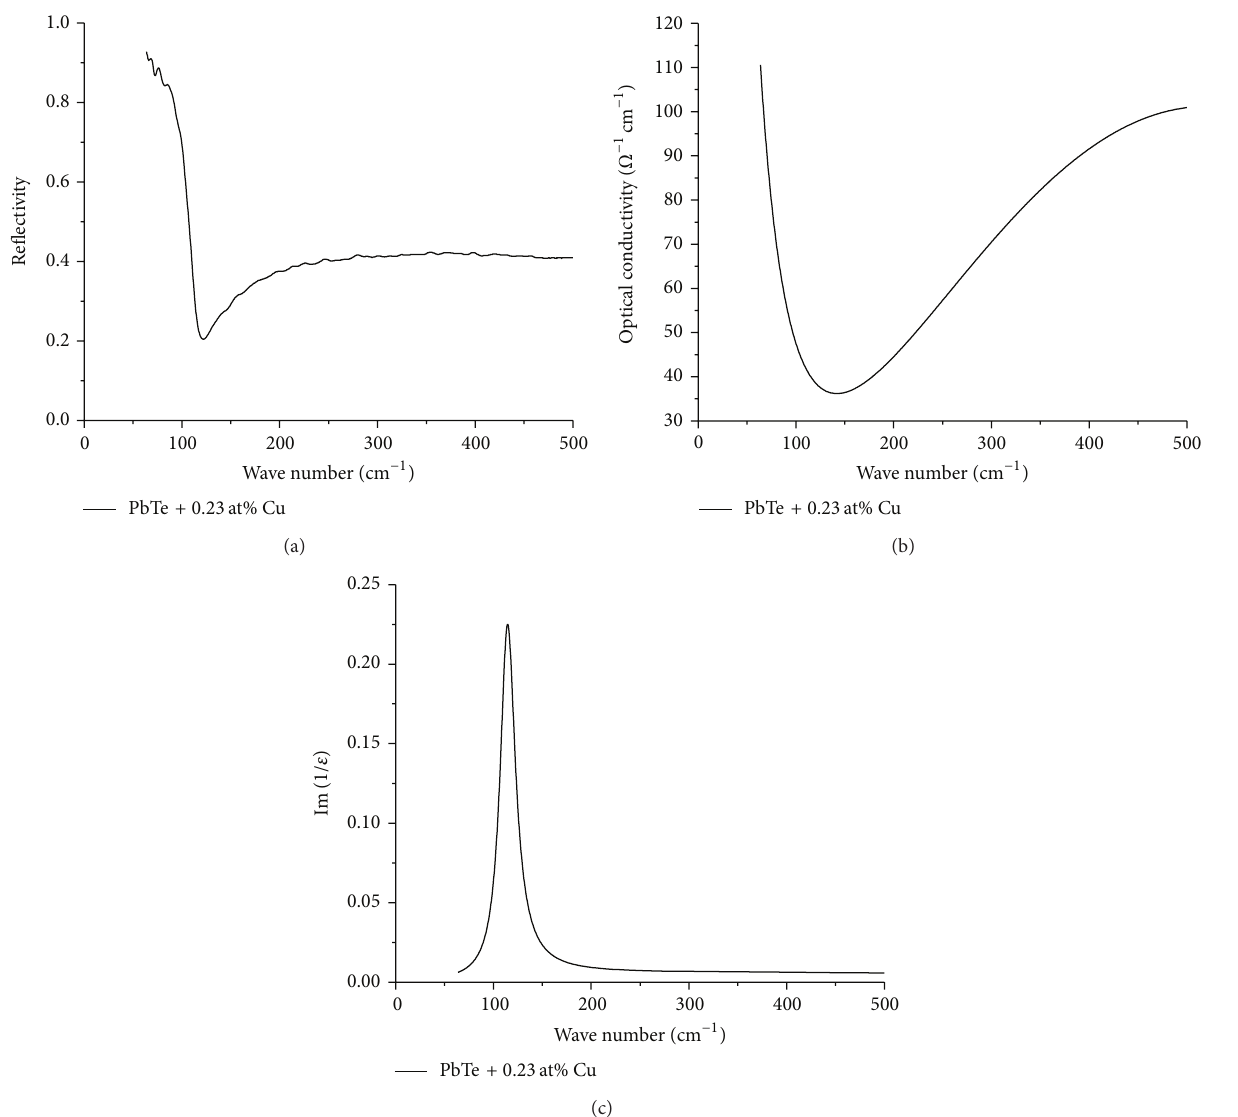
Figure 5: (a) Optical reflectivity diagram for PbTe doped with 0.23 at% Cu, (b) its optical conductivity, and (c) reciprocal values of imaginary part of dielectric constant [Im (1/𝜀)